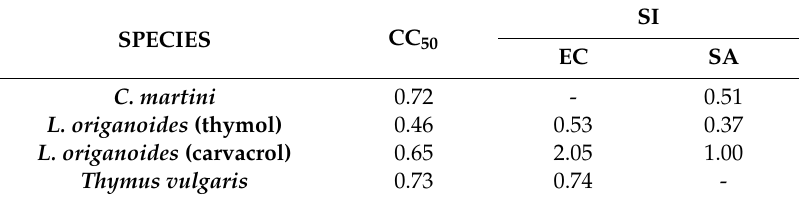
Table 4. Selectivity index (SI) of the EOs in E. coli O157:H7 (EC), SARM (SA).